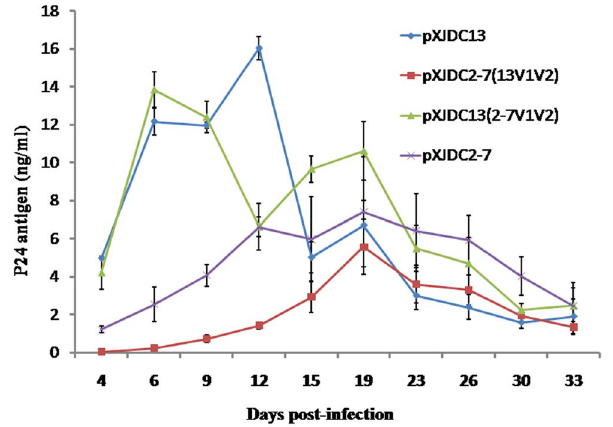
Figure 7. Replication kinetics of the chimeric viruses derived from the molecular clones pXJDC13(2-7V1V2) and pXJDC2- 7(13V1V2), in comparison with parental clones pXJDC13 and pXJDC2-7. 3 6 10 6 PHA-stimulated PBMCs were infected with viruses normalized at 400 TCID 50 in triplicate. Virus production was monitored by measuring HIV-1 p24 antigen concentration in culture supernatant every 3–4 days. The results shown are the mean value with standard deviations from three independent experiments.